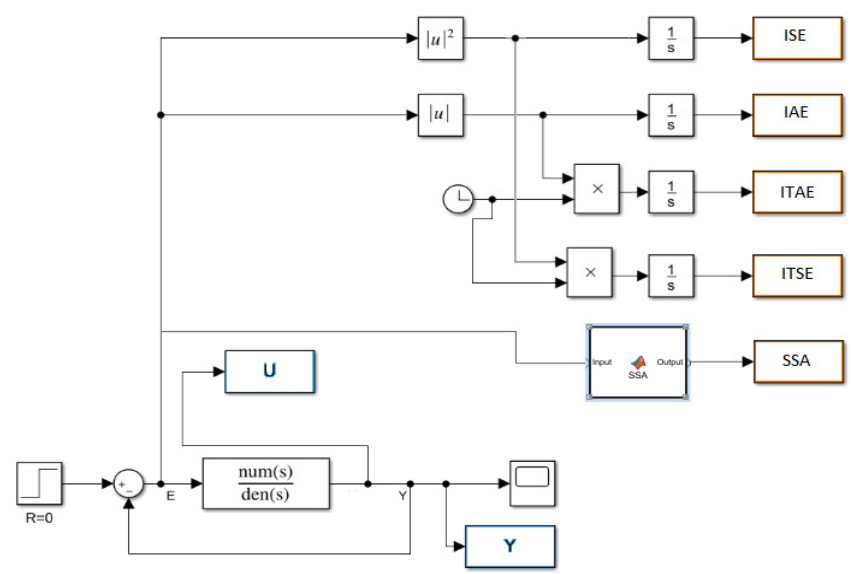
Figure 14. Simulink model and testing the results of ISE, IAE, ITAE, ITSE, and SSA.